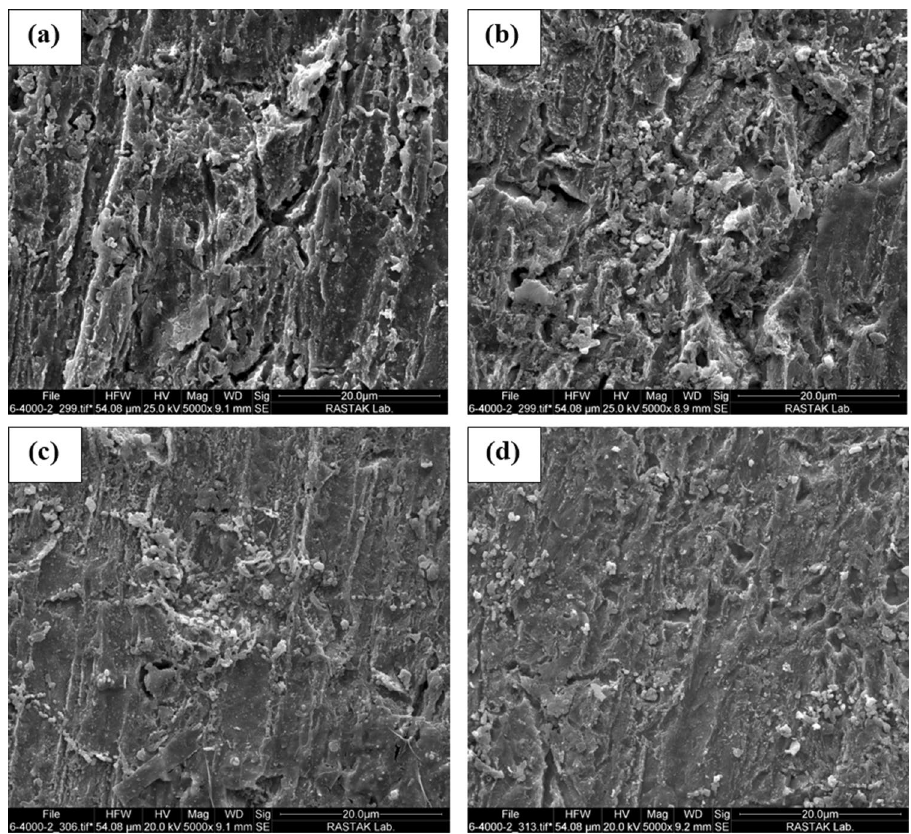
Figure 9. SEM images of MS samples after exposure to ( a ) 0; ( b ) 100, ( c ) 200, and 300 ( d ) ppm